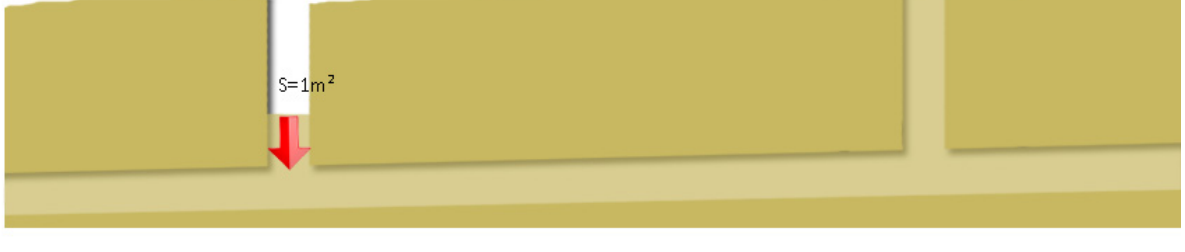
Figure 21. Well digging.